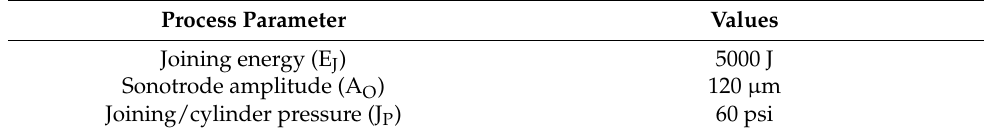
Table 4. Optimized U-Joining horizontal parameters for 316L SS/PEEK-20CF hybrid joints. Process